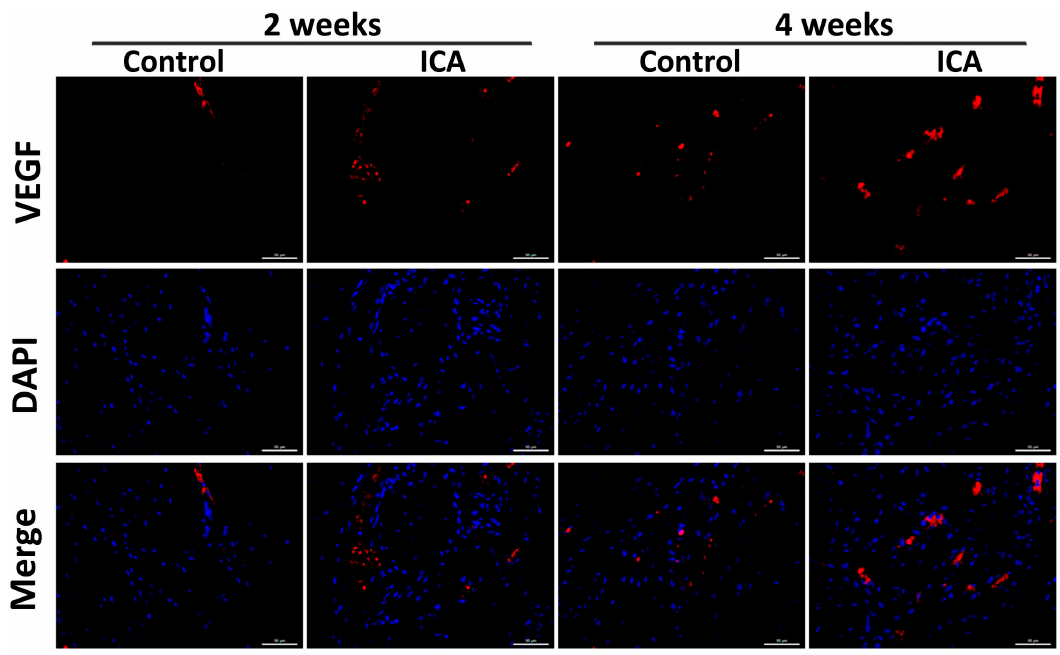
Figure 6. Results of the immunofluorescence staining of VEGF. The results of immuno-fluorescence staining of the samples showed that the VEGF protein expression was significantly increased after ICA treatment, which confirmed the findings of immunohistochemical staining and demonstrated that ICA improved angiogenesis, bar = 50 μ m.